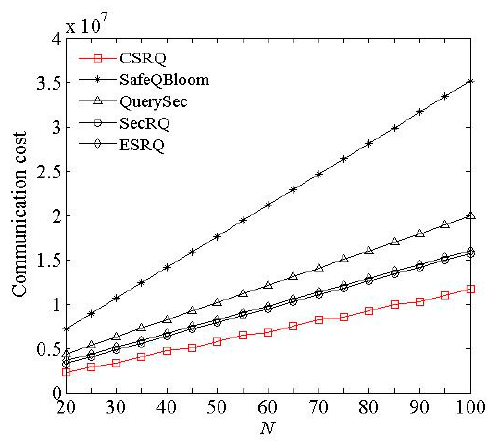
Figure 4. Impact of N on communication cost.